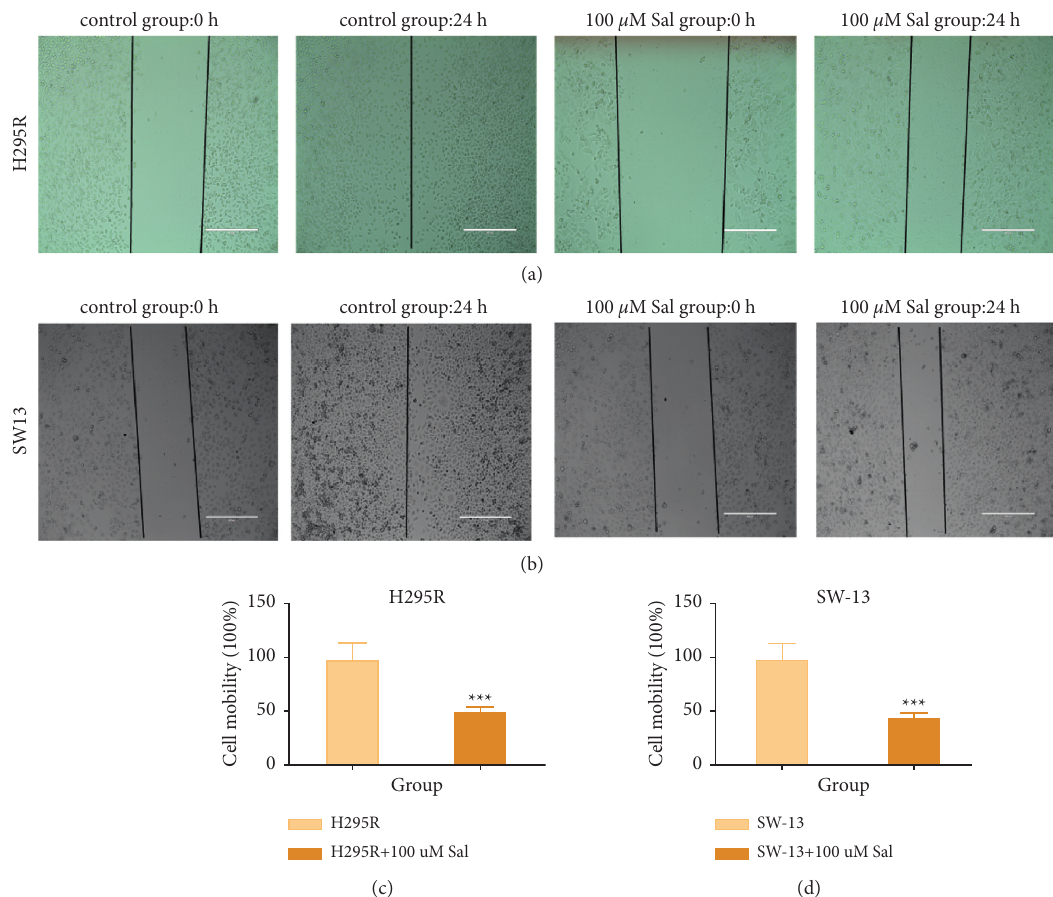
Figure 2: The effect of Sal in inhibition of the migration of ACC cells. (10 × , scale bar is 400 μ m). (a, b) Cell migration of H295R and SW-13 cells after being incubated with 0 μ m Sal or 100 μ m Sal for 0h and 24h. (c, d) Calculation of cell migration of H295R and SW-13 cell in A and B; ∗∗∗ p < 0 .